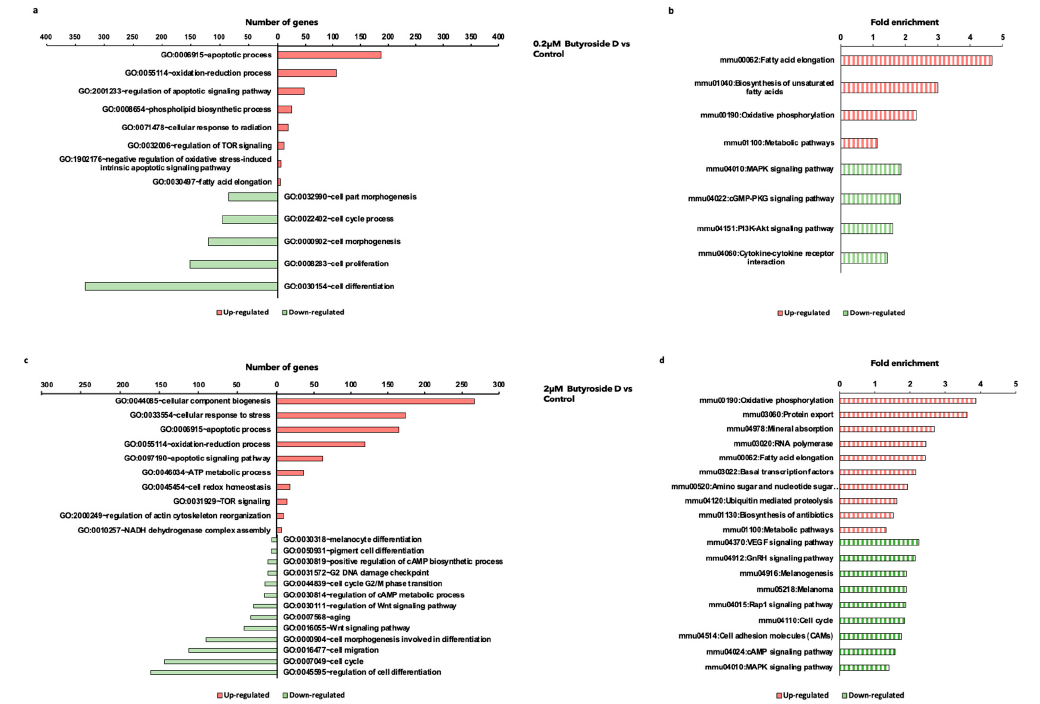
Figure 4. Butryoside D modulated biological processes and pathways related to melanogenesis. Summary of the top ( a ) up- and downregulated gene ontologies (GO) and ( b ) KEGG pathways stimulated by 0.2 μ M Butryoside D. Summary of the top ( c ) up- and downregulated gene ontologies (GO) and ( d ) KEGG pathways stimulated by 2 μ M Butryoside D. The red bars represent the upregulated genes and green bars represents the downregulated genes. The GO graph x -axis indicates the number of genes, and the y -axis represents the GOs. KEGG pathway graph x -axis reflects the fold change of the pathways indicated in the y -axis.